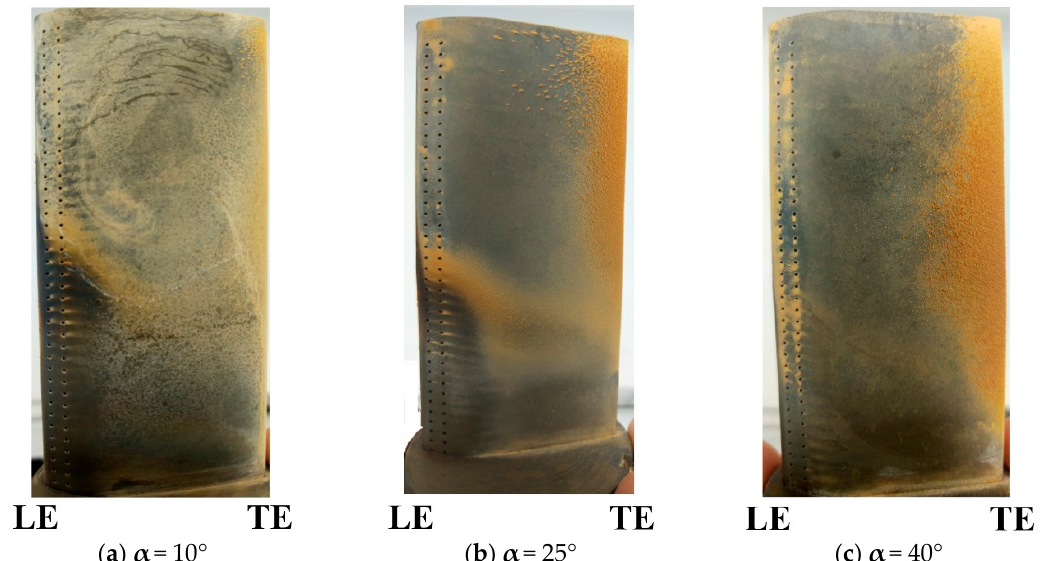
Figure 22. Images of the post-test blade suction side at different angles of attack: ( a ) 10°, ( b ) 25°, and ( c ) 40°.